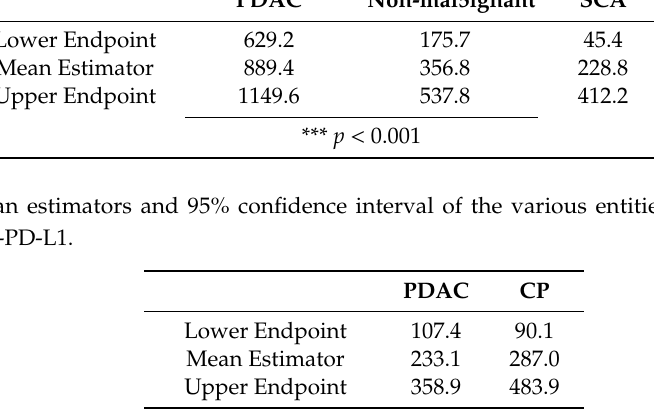
Table 3. Mean estimators and 95% confidence interval of the various entities using the primary antibody anti-c-Met. p -value is based on Mann–Whitney U test. *** significant at 0.1% level ( p < 0.001).